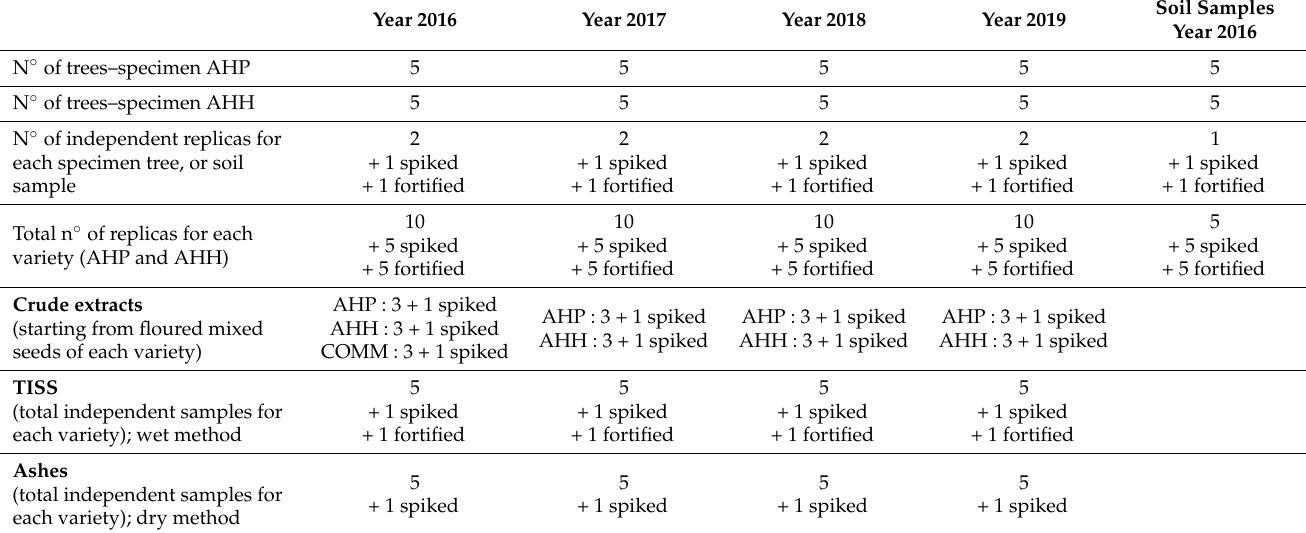
Table 1. Workplan of independent samples and sampling procedures (*) (#) for ICP-OES determinations, applied to different matrices originating from different horse chestnuts specimens (AHP and AHH) along the years 2016–2019, and growing soil samples analyzed in